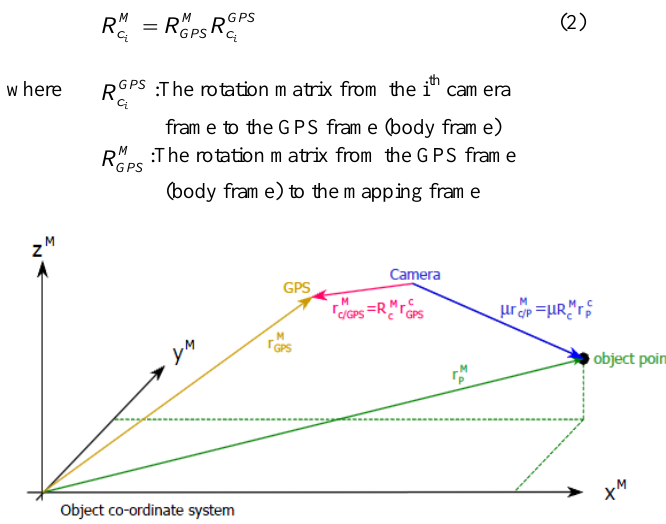
Figure 6. Relationship of GPS antenna center, camera perspective center, and an object point (Ellum,